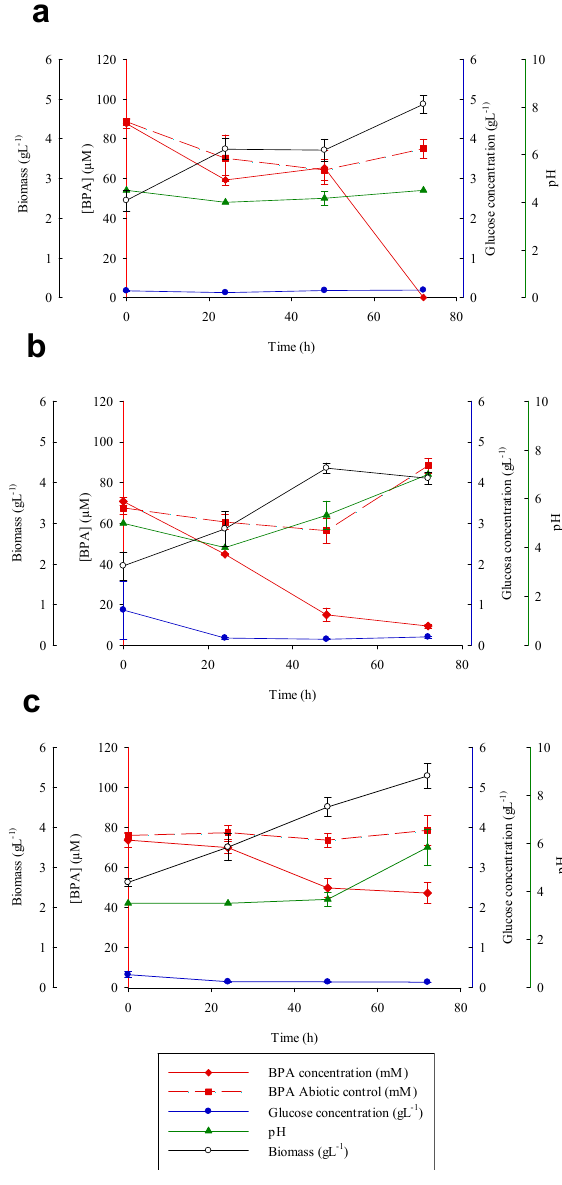
Figure 3. Comparison of bisphenol A elimination by Syncephalastrum monosporum ( a ), Talaromyces gossypii ( b ), and Talaromyces verruculosus ( c ). Bisphenol A concentration (red diamond), glucose concentration (blue circles), pH (green triangle), biomass (white circles), and the bisphenol abiotic control (red square) were measured. Error bars represent the standard deviation of three independent replicates.